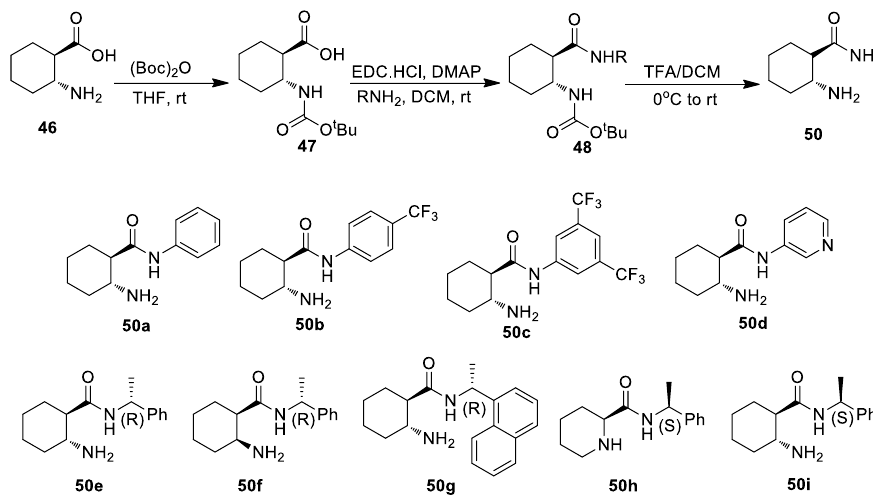
Scheme 19. Design and synthesis of various amino amide organocatalysts.